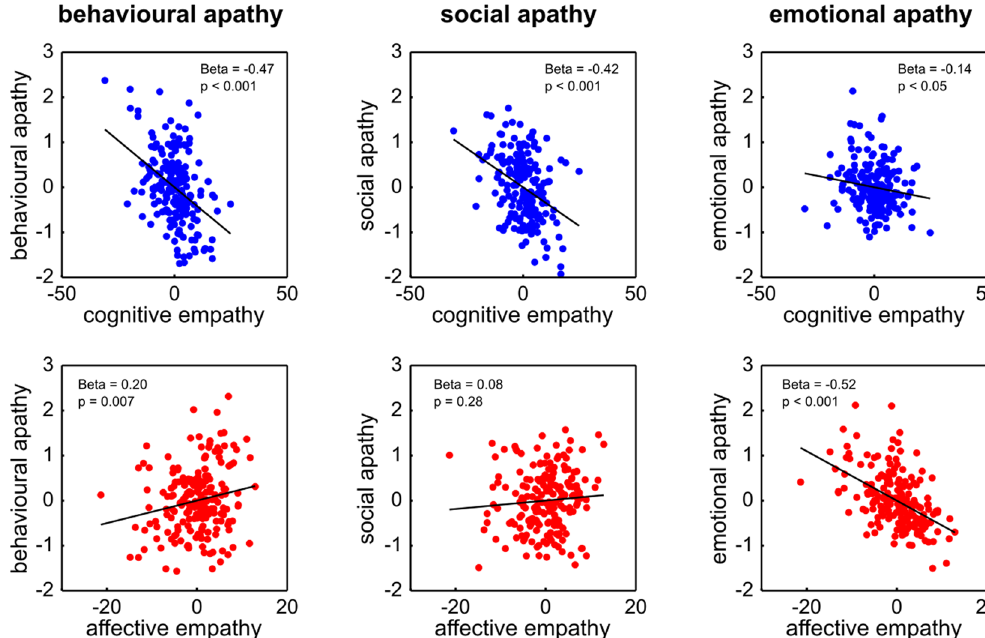
Figure 2. Relationships between domains of empathy and apathy in Sample 2. Replication of partial correlations from multiple regression models showing how unique variance associated with cognitive and affective empathy is associated with different domains of apathy-motivation (behavioural, social and